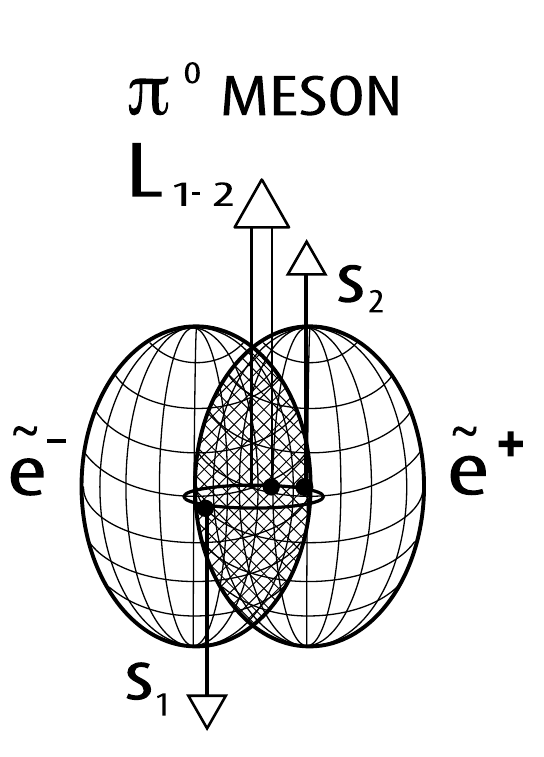
Figure 6: A conceptual rendering of the structure model of the π 0 meson as a hadronic bound state of one isoelectron ˜ e − and one isopositron ˜ e + in singlet coupling with un- mutated spins s = − s = 1 / 2 and orbital hadronic momentum in the ground state 1 2 L = 0 . The dashed area represents the contact, non-linear, non-local and non- 1 − 2 potential interactions responsible for the bound state that, being not representable with a Hamiltonian H , are representable via the isotopic element ˆ T in the iso-Schr ¨ odinger equation H (cid:63) ˆ ψ = H ˆ T ˆ ψ = E ˆ ψ